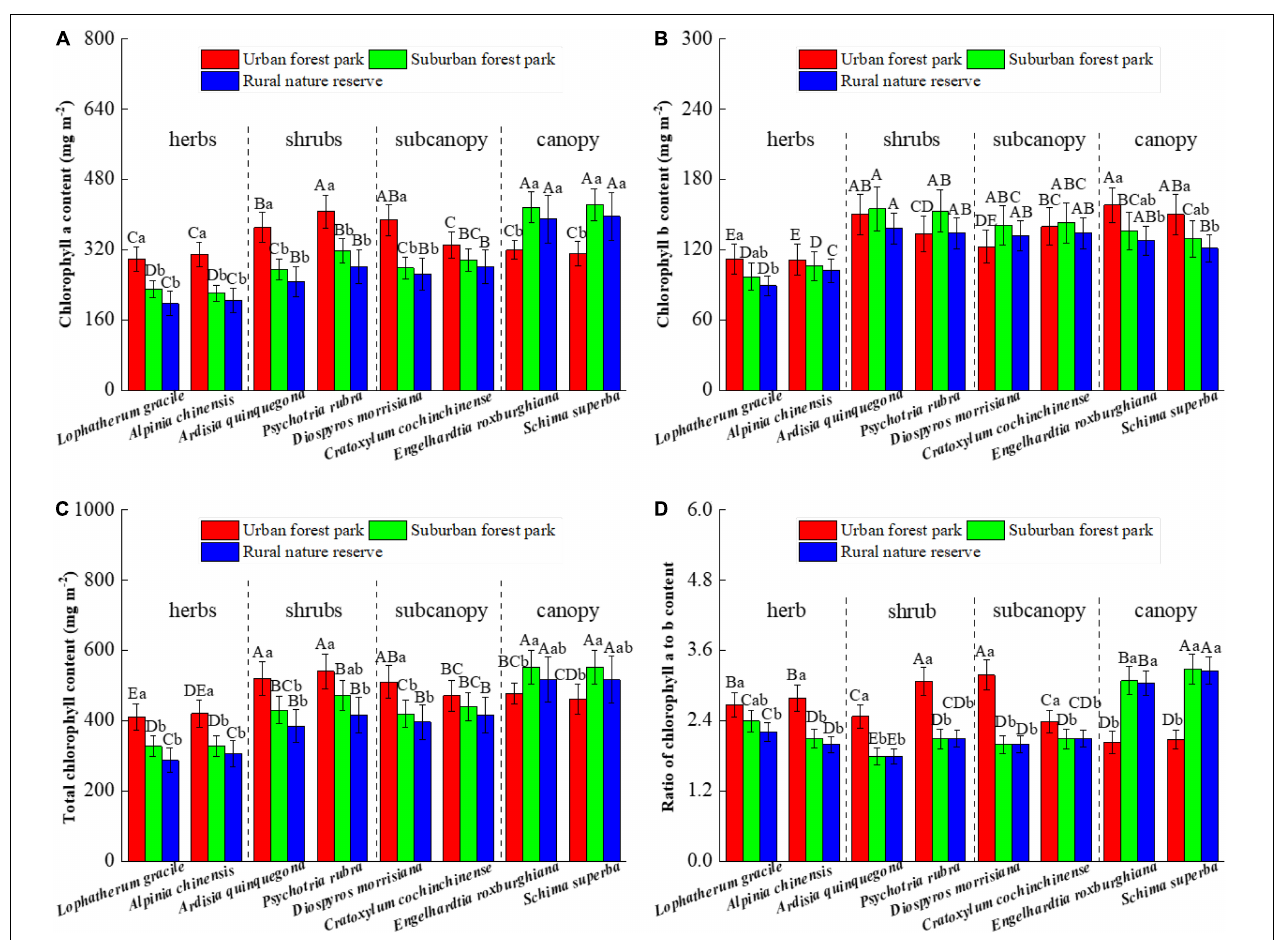
FIGURE 3 | Effects of growth environment on contents of (A) chlorophyll a, (B) chlorophyll b, and (C) total chlorophyll and (D) ratio of chlorophyll a to b of eight plant species. The lowercase letters reveal the significant differences ( P < 0.05 ) of the same species among different growth environments, and the capital letters reveal the significant differences ( P < 0.05 ) of different species in the same growth